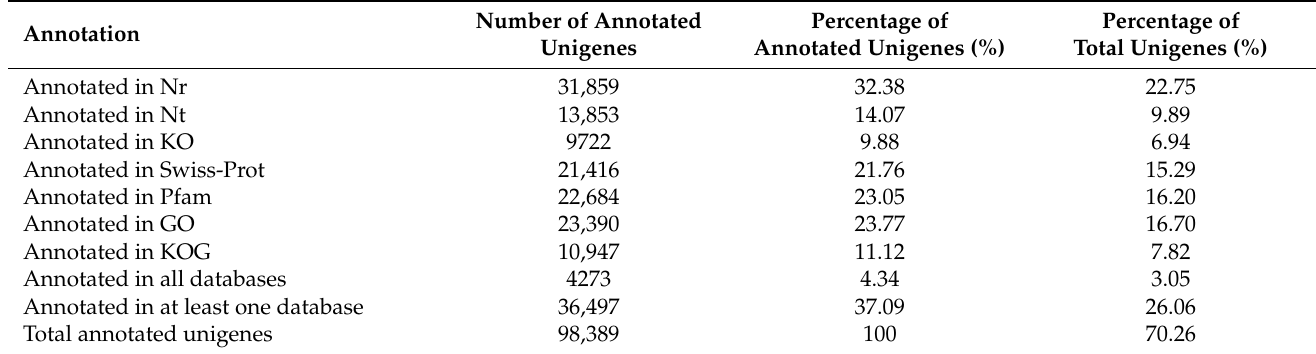
Table 2. The statistics of the unigenes’ annotation in the flower transcriptome of L. yunnanensis